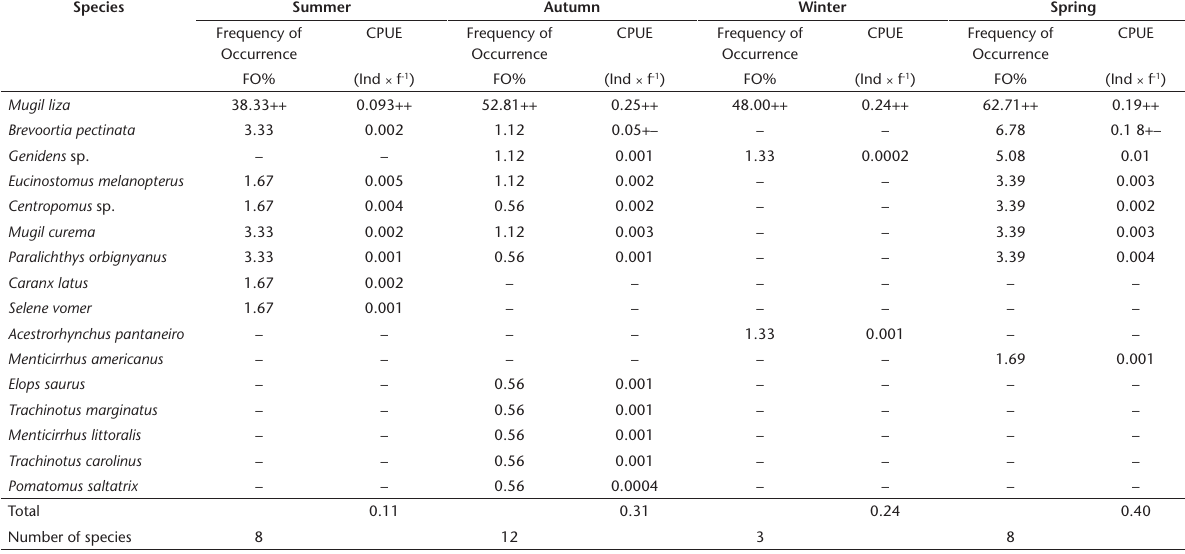
Table 2. List of species caught by cast net fishermen in cooperation with dolphins at the entrance channel of the ESTR, along with fre- quency of occurrence (%FO) and number of individuals per unit of effort (CPUE). Species were classified as: abundant and frequent ( ++ ), abundant and infrequent (+–), frequent and not abundant (–+), infrequent and not abundant (absence of the signals) and absent (–). Species